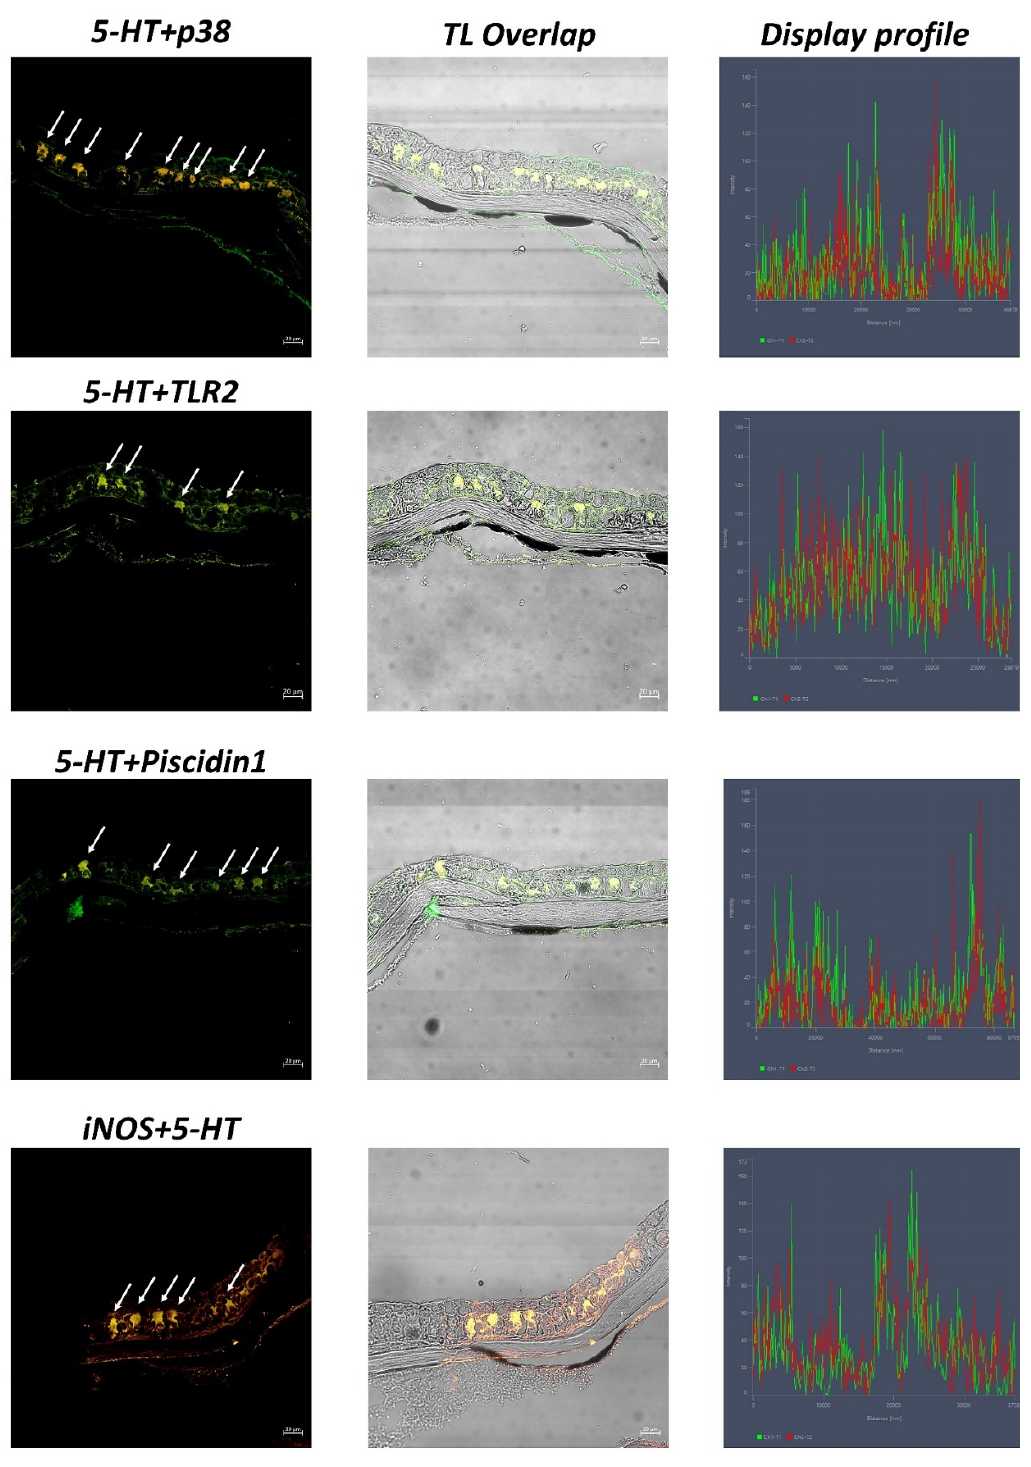
Figure 5. Cross section (5 μ m thick) of zebrafish skin. Colocalization of antibodies tested. Immunofluorescence 20×, scale bar 20 nm. CCs immunopositive are colocalized for antibodies tested (arrows). The “display profile” function confirms these data. TL = Transmitted Light.